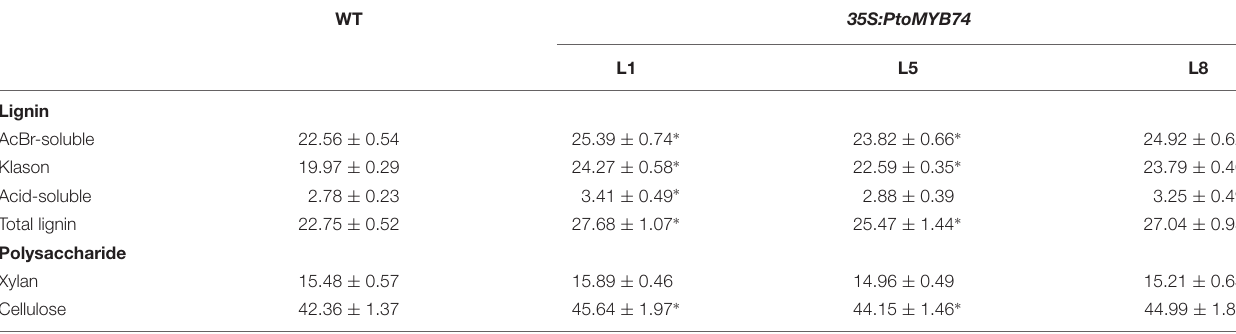
TABLE 2 | Secondary cell wall composition analysis of the stems in wild-type and PtoMYB74 overexpression plants.